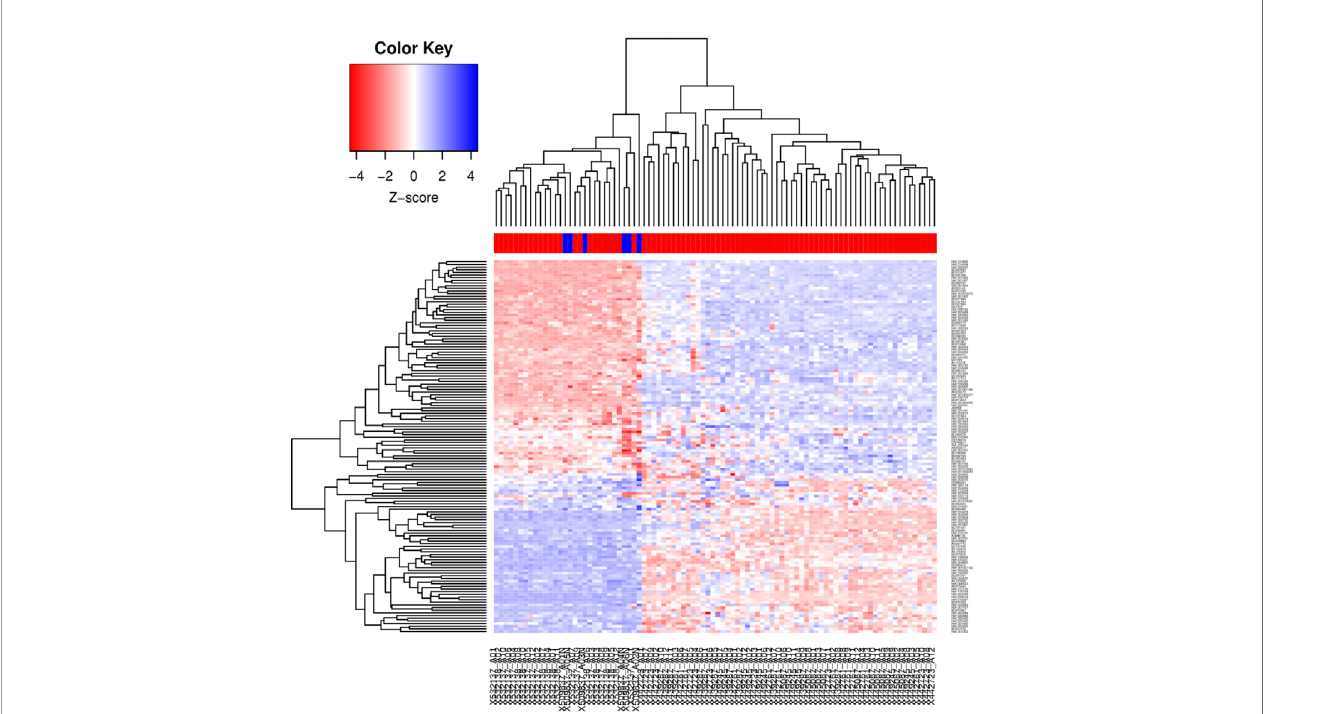
FIGURE 1 | Hierarchical cluster generated from 89 LACC and 6 non-tumor tissue samples. Cluster analysis of the microarray data. The microarray data were analyzed by the Genesis program. The cluster shows 249 genes (137 up-regulated and 112 down-regulated). Each row represents a gene, whereas each column corresponds to a tissue sample, the color line above the tissue samples indicates the sample type: normal samples (blue) and tumor samples (red). The relative abundance of each gene in the tissue correlates with the color intensity (red, induced; blue, repressed; white, no change). In the dendrogram, all six normal cervical samples clustered together, indicating their similarity based on the expression pro fi